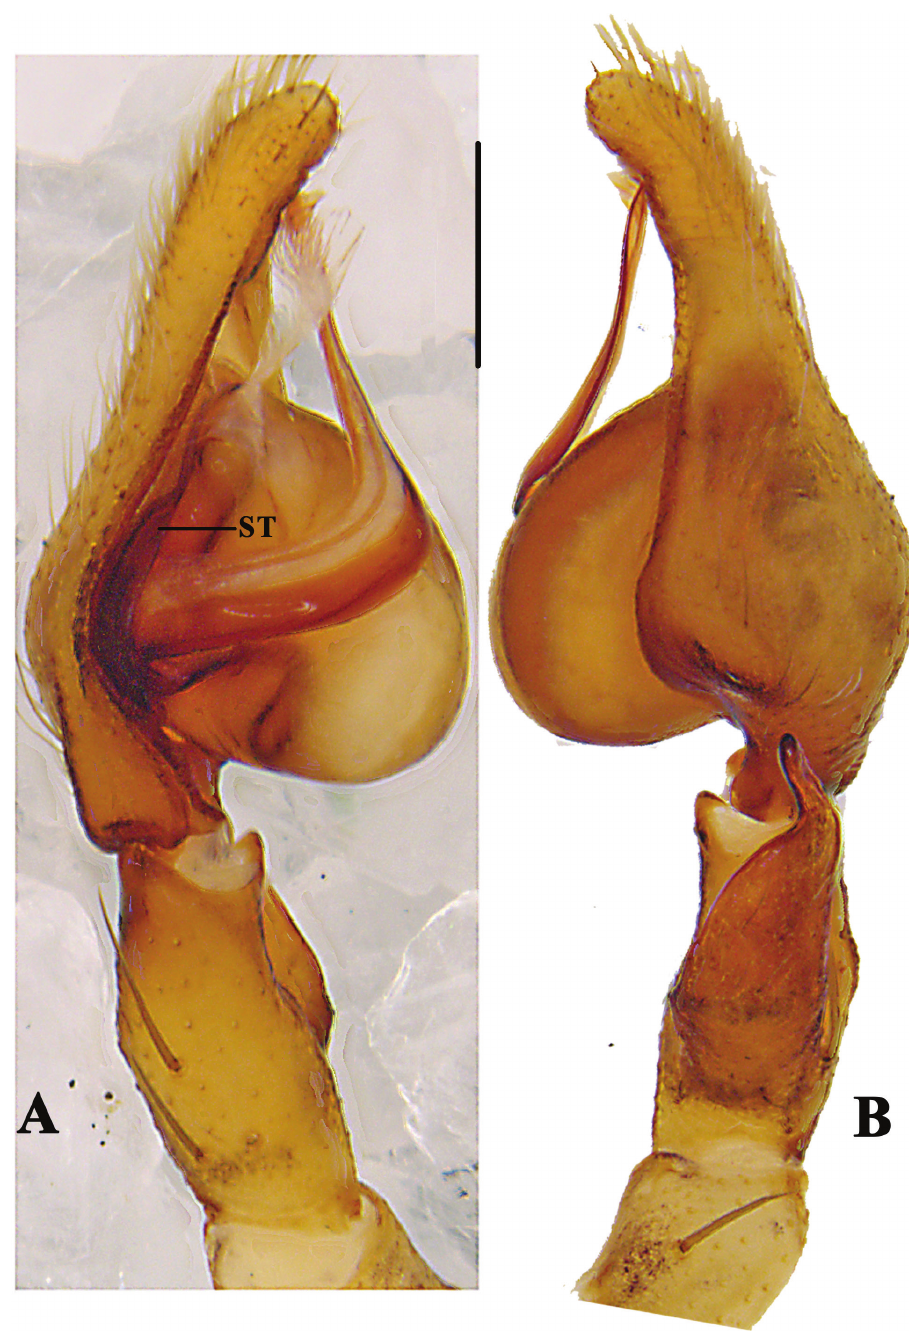
Figure 3. Pseudopoda bibulba Xu & Yin, 2000 A left male palp, prolateral B same, retrolateral. Abbrevia- tion: ST–subtegulum. Scale bar: 0.5